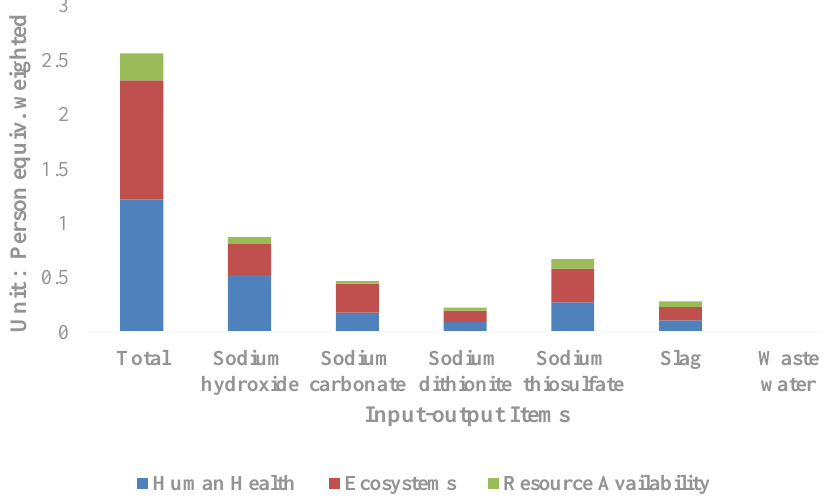
Figure 4. Comparison of the life cycle impact indicators of input–output items of the silver separation processes.